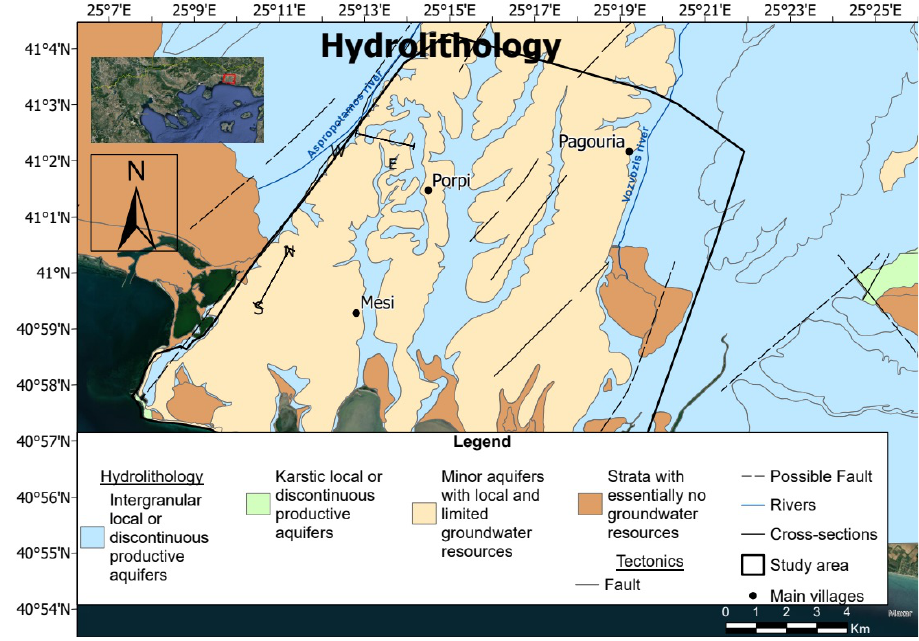
Figure 1. The hydrolithology of the study area.